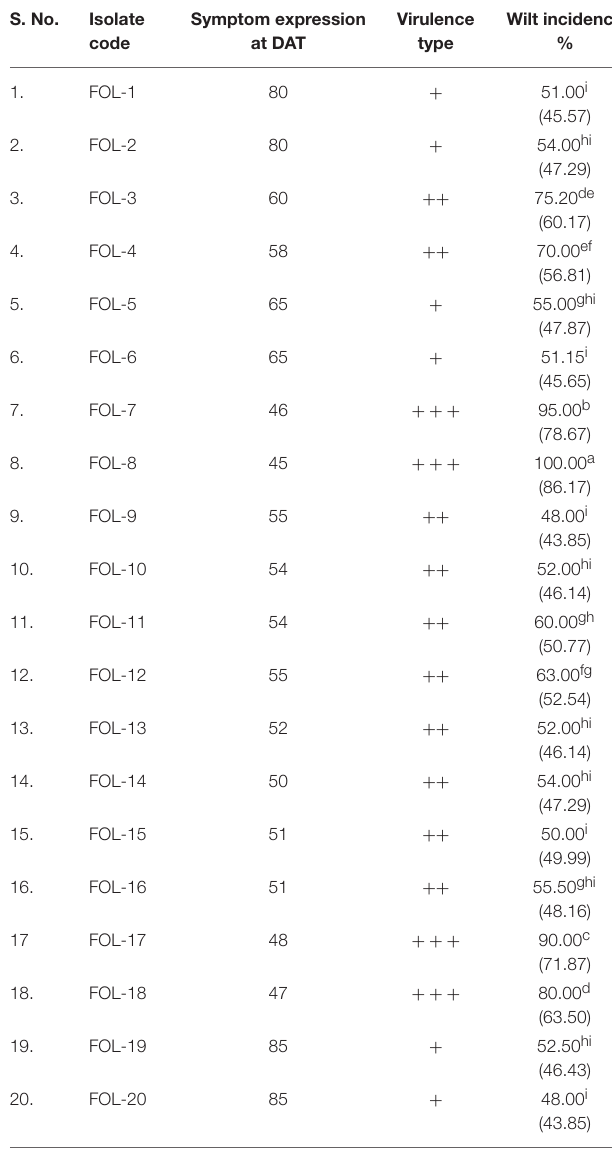
TABLE 3 | Determination of virulence based on the pathogenicity of F. oxysporum f.sp. lycopersici isolates under glasshouse conditions. S.